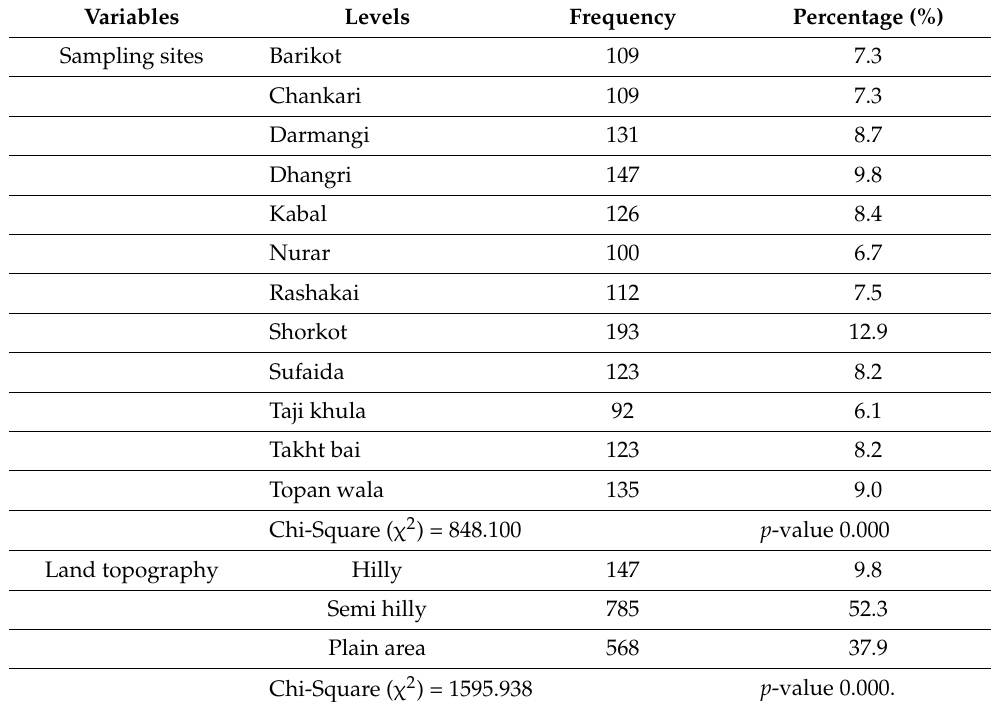
Table 5. Frequency distribution of hard ticks with reference sampling sites, land topography, host gender, and age groups in sheep and goats.